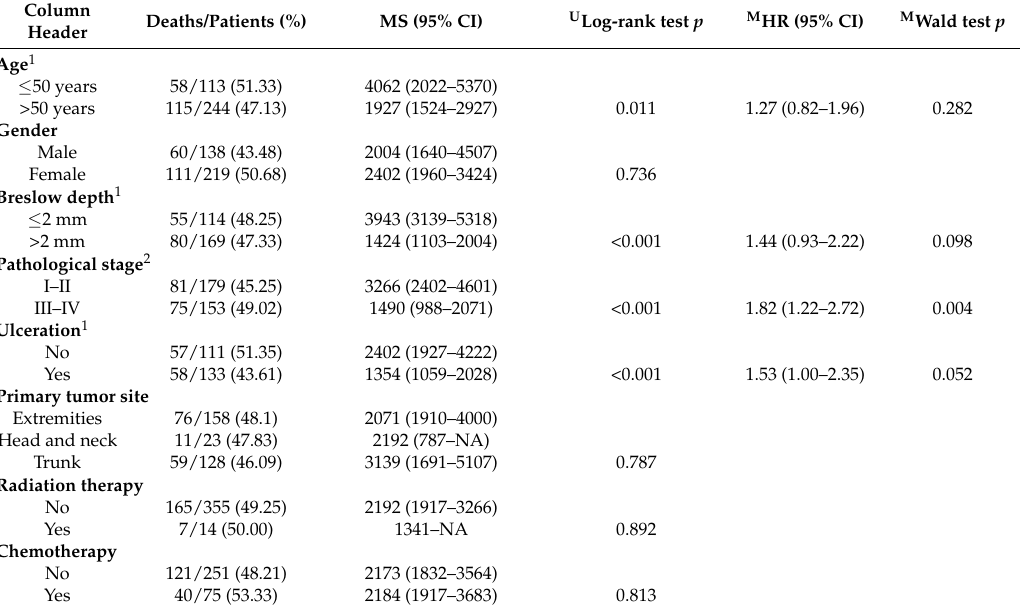
Table 1. Survival analysis of demographic and clinicopathological characteristics based on